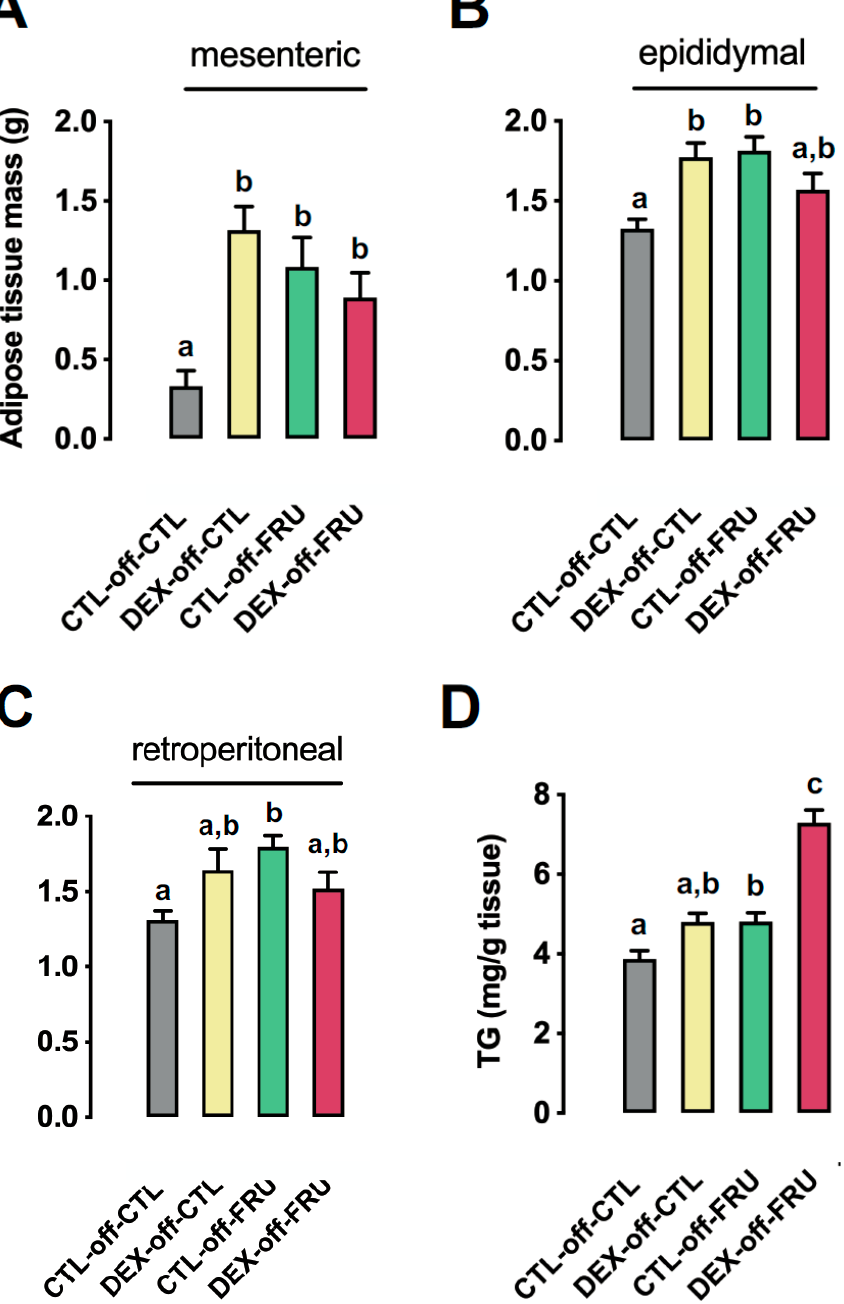
Figure 2. E ff ects of fructose on the relative fat pad weights and hepatic triglyceride contents in rats exposed to DEX in utero. ( A ) Mesenteric, ( B ) epididymal, and ( C ) retroperitoneal fat pads of the CTL-o ff -CTL, DEX-o ff -CTL, CTL-o ff -FRU, and DEX-o ff -FRU groups were excised and expressed relative to body weight. ( D ) Fragments of liver were subjected to lipid extraction and subsequent triglyceride determination ( D ). The results are presented as the mean ± SE. Means with di ff erent superscript minuscule letters are significantly di ff erent. The p values are provided in Section 3. N =